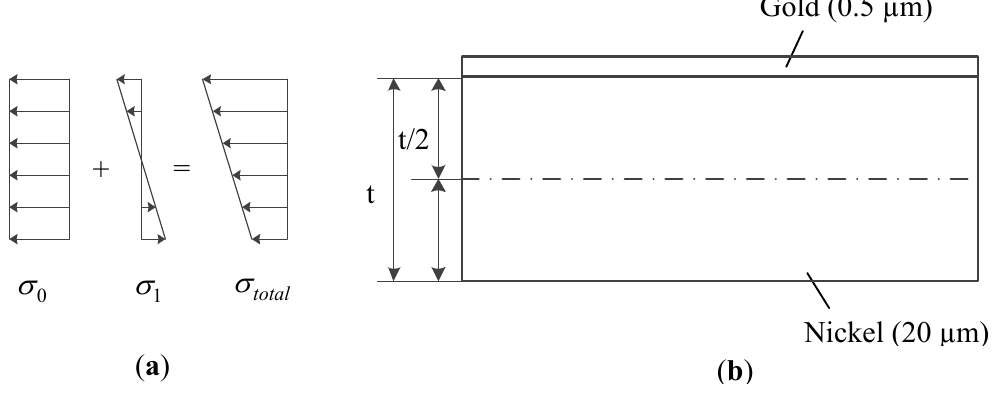
Figure 12. ( a ) Stress distribution in a homogenous cantilever, ( b ) composition of the sensing comb drives in the demonstrated